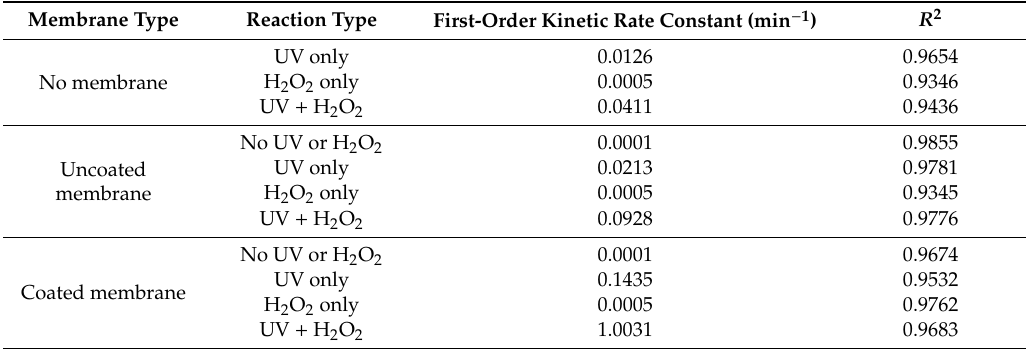
Table 2. First-order degradation kinetics rate constants of SMX under different experimental conditions in Figure 2a with the uncoated and coated ceramic membranes.